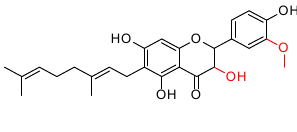
Figure 4. Structures of discussed flavanonols.